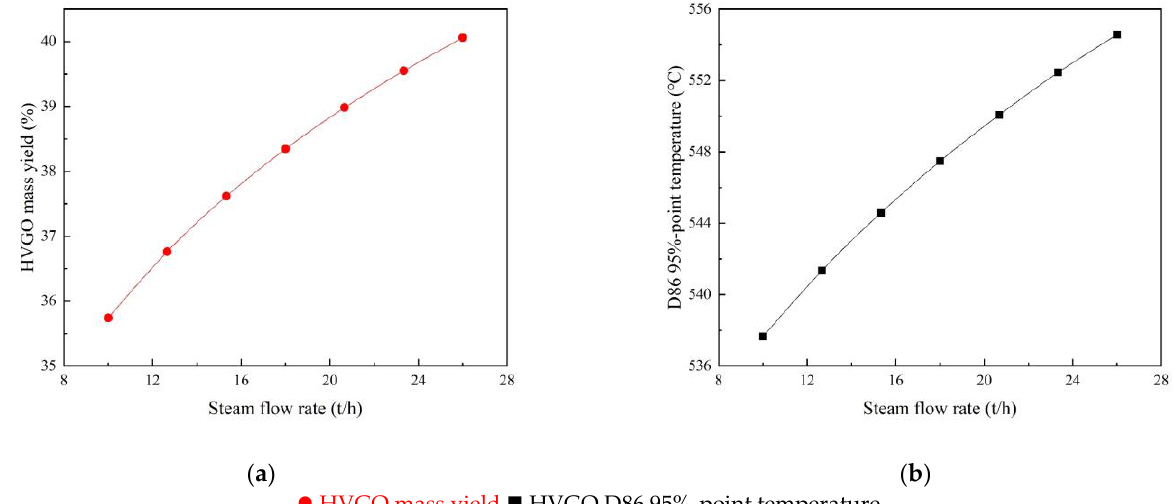
Figure 11. Effect of SFR on deep-cut vacuum distillation. ( a ) HVGO yield change; ( b ) HVGO D86 95%-point temperature change.